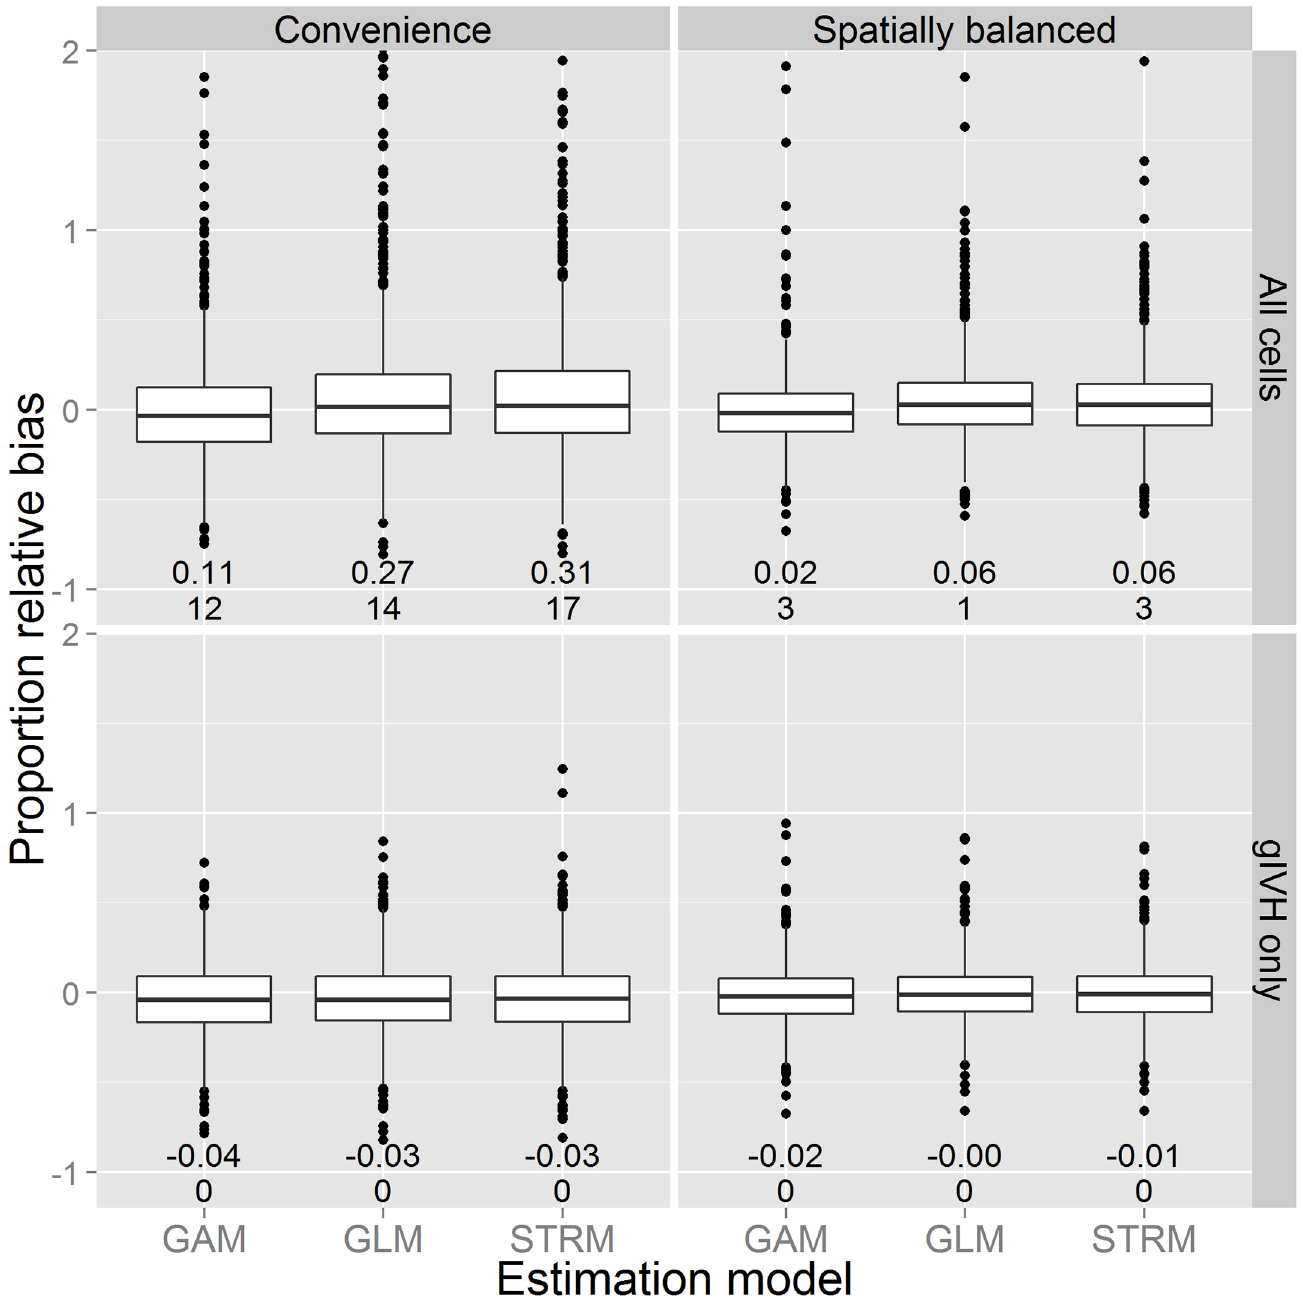
Fig 6. Boxplots summarizing proportional error in abundance from the simulation experiment. Each boxplot summarizes the distribution of proportional error in the posterior predictive median of abundance as a function of estimation model (x-axis), survey design (columns) and whether or not inference was restricted to the gIVH (rows). The lower and upper limits of each box correspond to first and third quartiles, while whiskers extend to the lowest and highest observed bias within 1.5 interquartile range units from the box. Outliers outside of this range are denoted with points. Horizontal lines within boxes denote median bias. The two numbers located below each boxplot indicate mean bias (upper number) and the number of additional outliers for which proportional bias was greater than 2.0 (lower